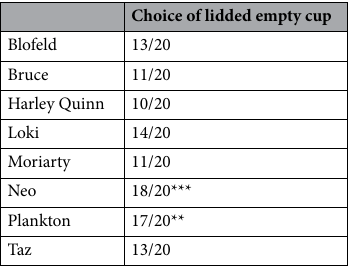
Table 2. Individual preferences for the lidded cup when both cups were presented empty. ** p < 0.01 , *** p < 0.001.